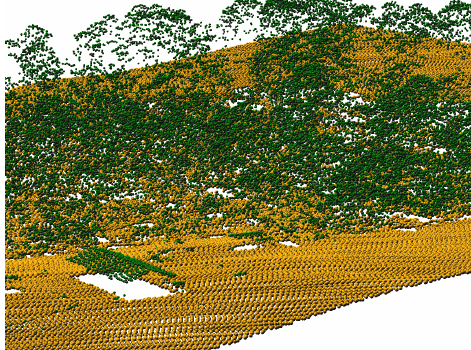
Figure 5: Point cloud obtained using airborne lidar in a small selected area with a patch of trees in the middle and a building (same as in Figure 6). Points classified as ground by progressive morphological filtering from PDAL are in yellow; all the other points are in